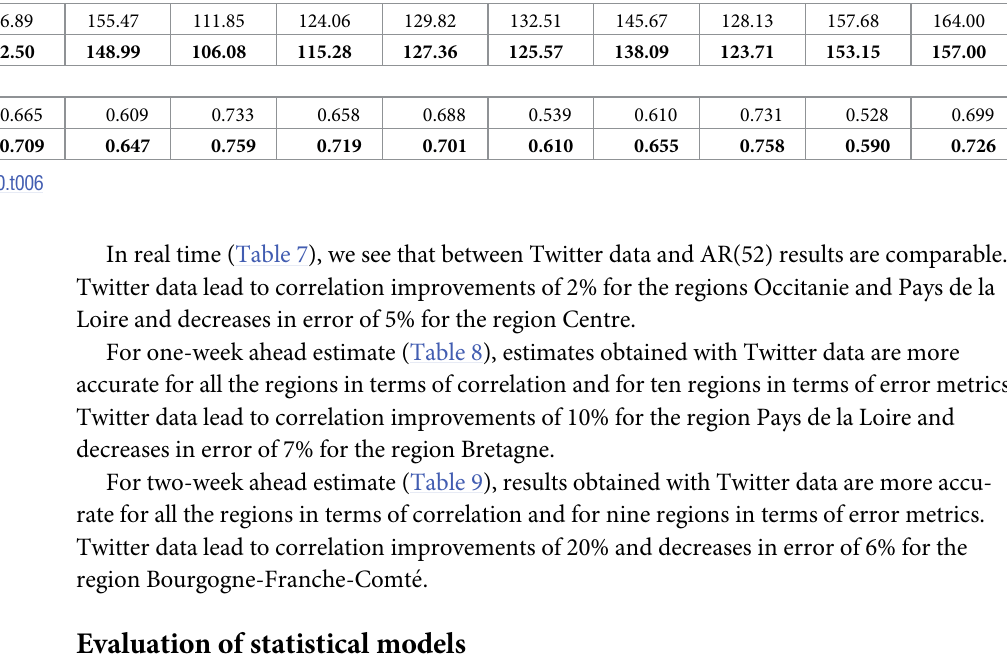
Table 6. Two-week ahead estimates—RMSE and PCC for ARGO models including only historical data (AR(52)) and only climatic data, for the period starting from January 2015 to March 2017. Auv. Bour. Bre. Cen. Gd Est Ht Fra. Ile Fra. Norm. Aqui. Occi. Pro. RMSE